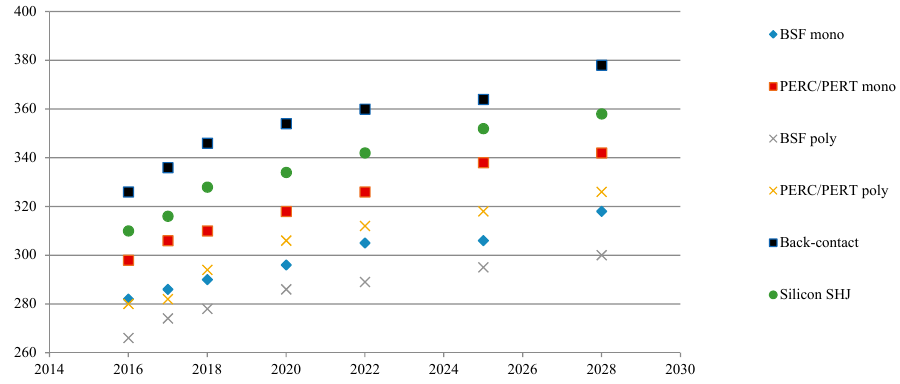
Figure 9. c-Si solar cell efficiency gain trend (%) [26,42].